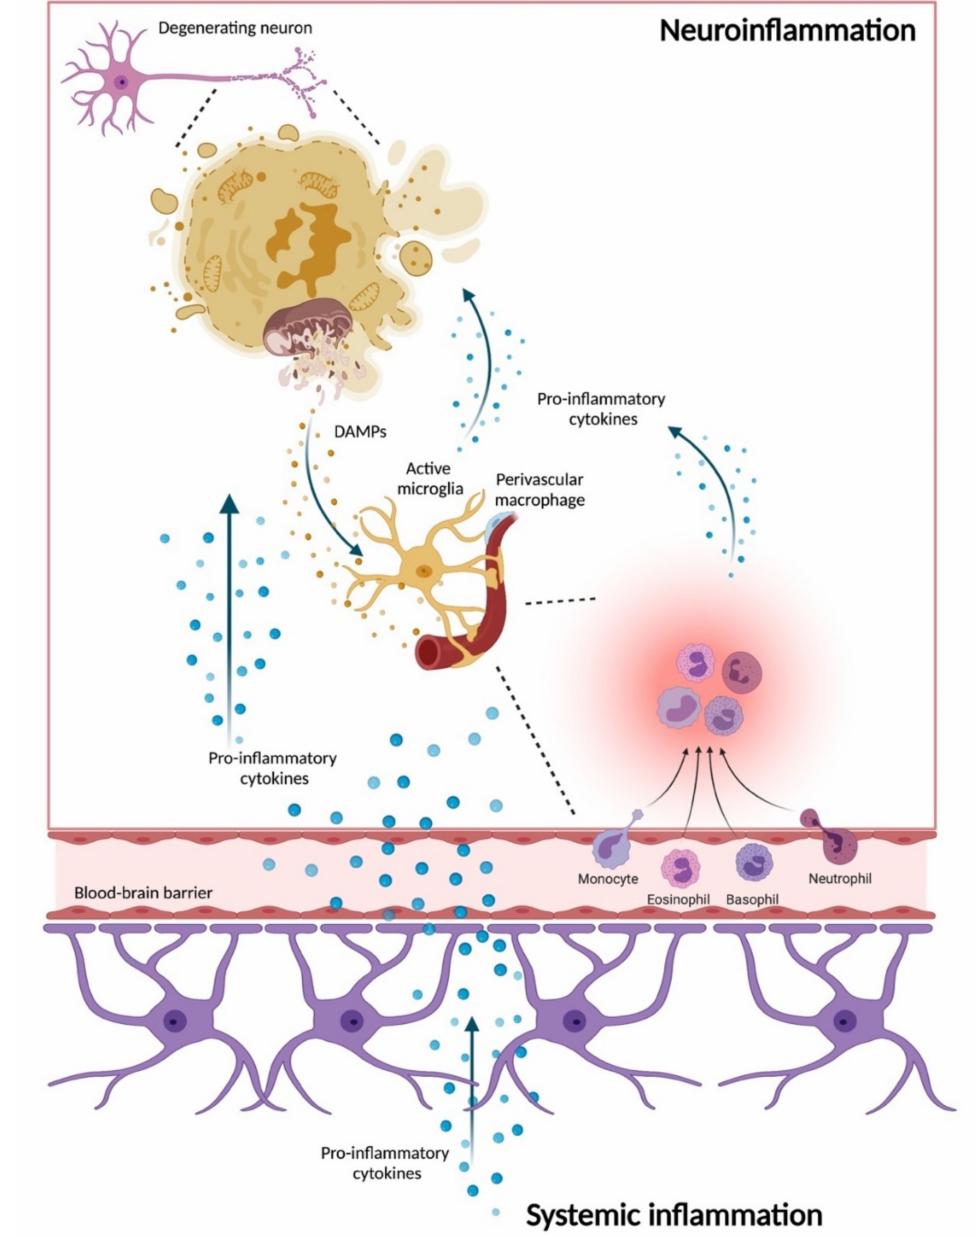
Figure 2. Schematic representation of the events linking peripheral and neuronal inflammation in Parkinson’s disease. The release of damage-associated molecular patterns (DAMPs) from damaged neurons, including mitochondrial DNA, can be sensed by the microglia which, in coordination with systemic inflammation, recruits inflammatory mediators to fight local impairments and triggers the release of a set of inflammatory mediators to install a pro-inflammatory phenotype in the long term. Microglia activation perpetuates a vicious circle for cytokine release, thereby installing a neuroinflammatory milieu. Created with BioRender.com, accessed on 24 September